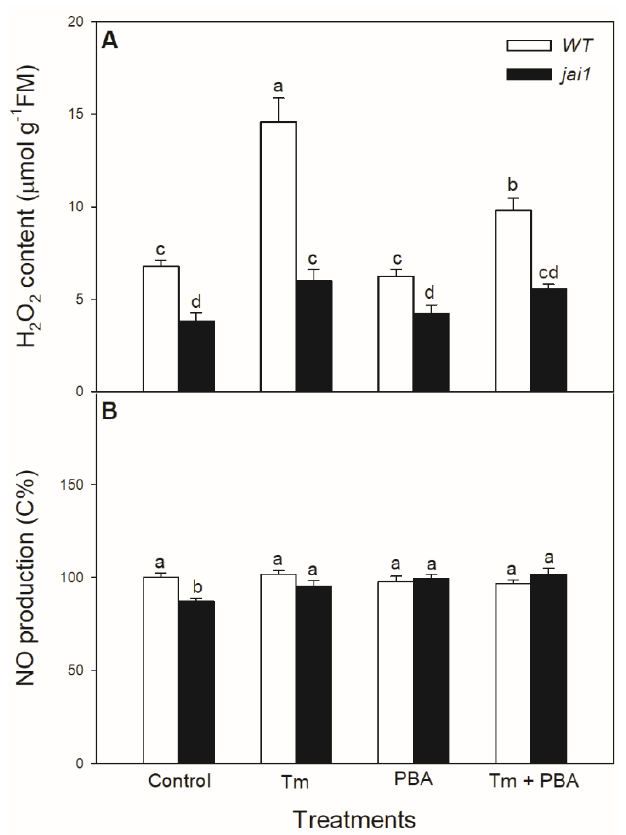
Figure 7. Changes in H 2 O 2 content ( A ) and NO production ( B ) in the leaves of wild-type (WT) and JA signalling mutant ( jai1 ) tomato plants exposed to 5 μ g mL − 1 tunicamycin (Tm), 1 mM 4-phenylbutyrate (PBA), and Tm + PBA for 6 h. Results are the means ± SE. Data with different letters indicate significant differences at p < 0.05 level, n = 3.